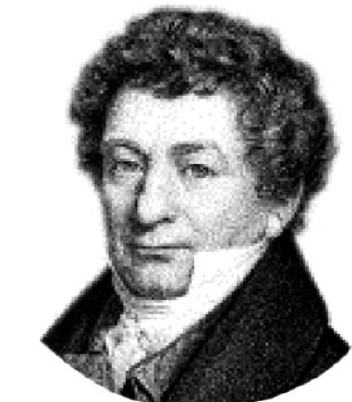
Figure 2. Friedrich Wilhelm Adam Sertürner (1783-1841) who isolated the substance from opium with alkaline character that he called “Morphine”, a name with a clear mythological reference: the Greek God of dreams